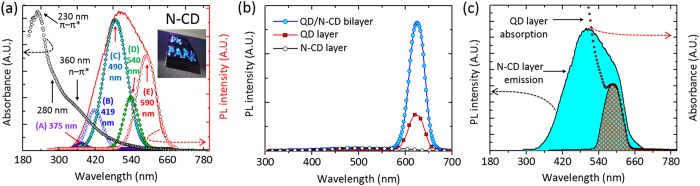
Optical properties of N-CD layer.(a) UV–visible absorption and PL spectra of N-CD layer. The PL band was de-convolved by multiple peak fitting. Inset is photograph of N-CD film lettered on Si substrate, taken under UV illumination. (b) PL spectra of N-CD, QD, and QD/N-CD layers. (c) PL spectrum of N-CD layer (black line) and UV–visible absorption spectrum of QD layer (red circles). The spectral overlap is marked with red checker.